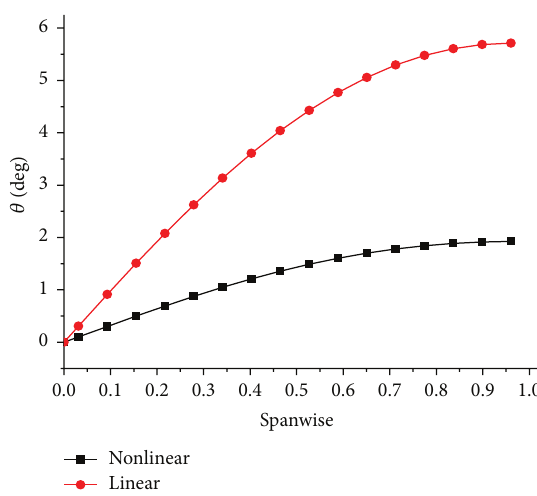
Figure 14: Torsional angle of the wing spar spanwise (0.5 ∘ AOA, 34